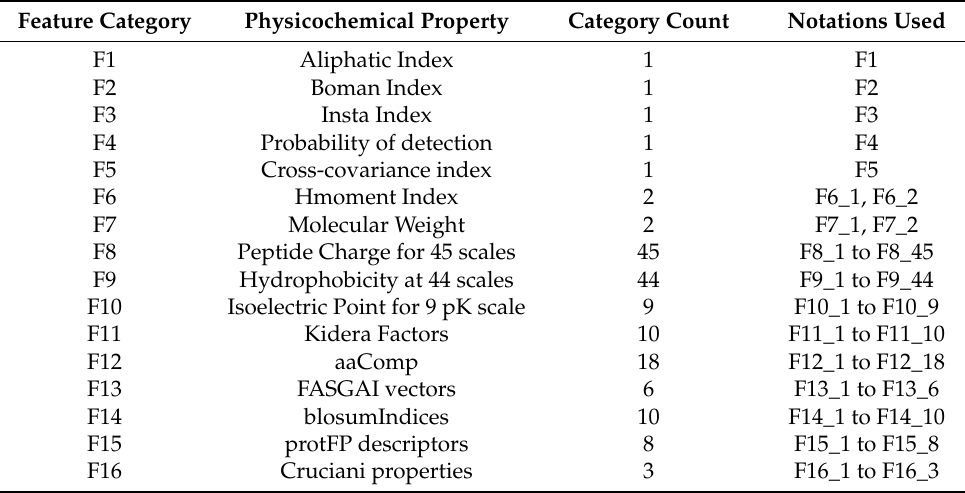
Table 2. Physicochemical properties used.